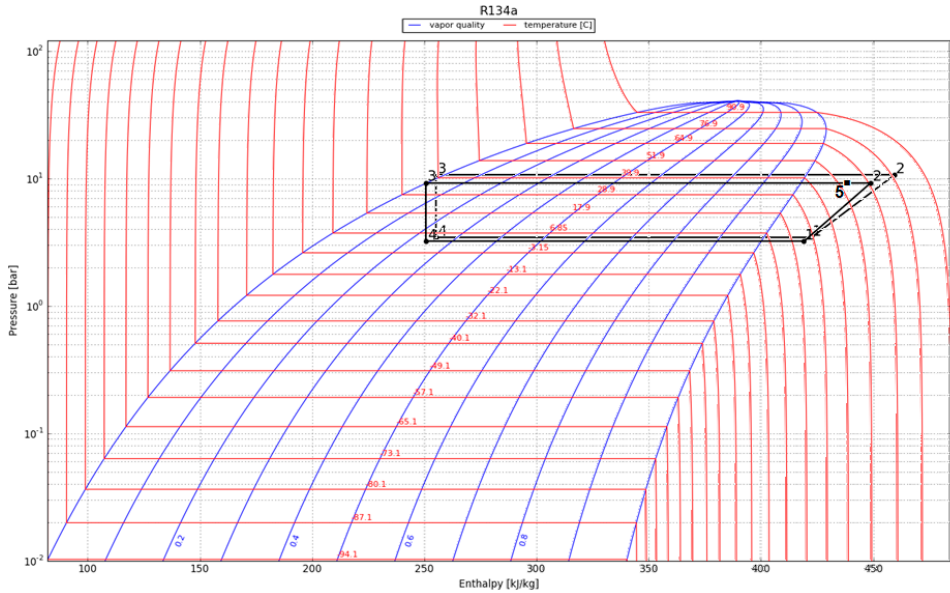
Figure 15. Analysis of p-h diagram of refrigeration system with and without HE-TEGs unit. Solid lines represent basic system and dotted lines represent the system with HE-TEGs unit.